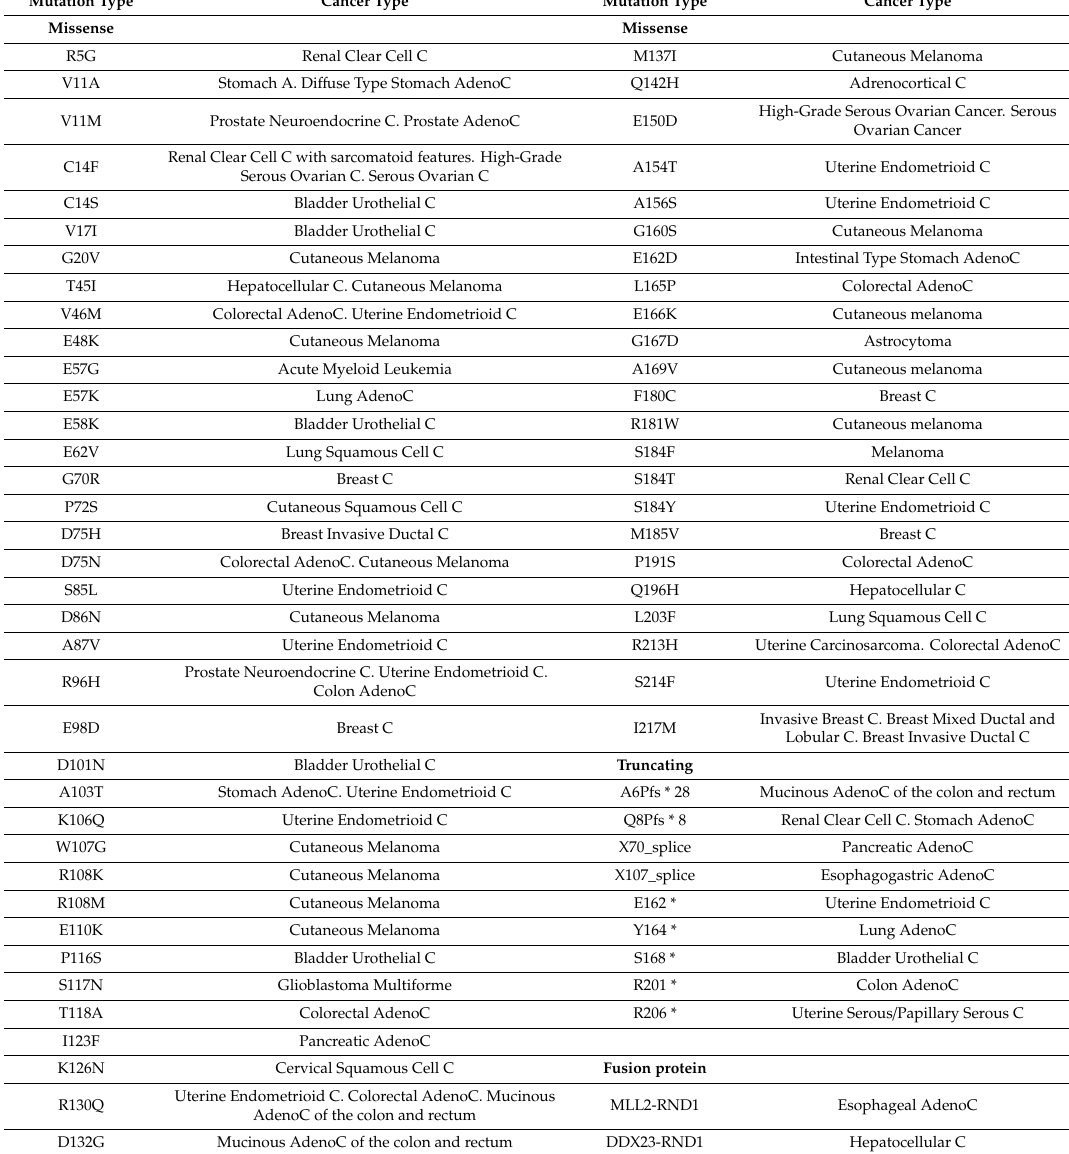
Table 1. Mutations in the RND1